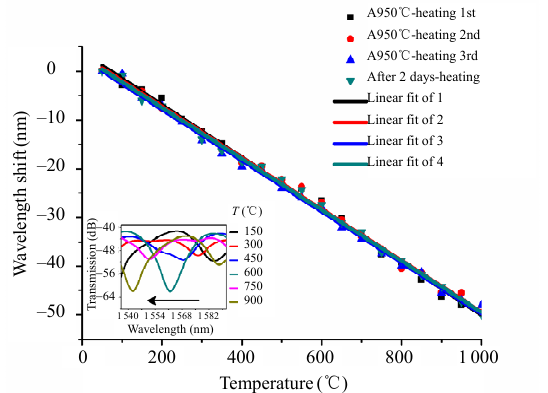
Fig. 10 Test of repeatability and reliability about wavelength shift versus temperature for the sensor after the annealing process.